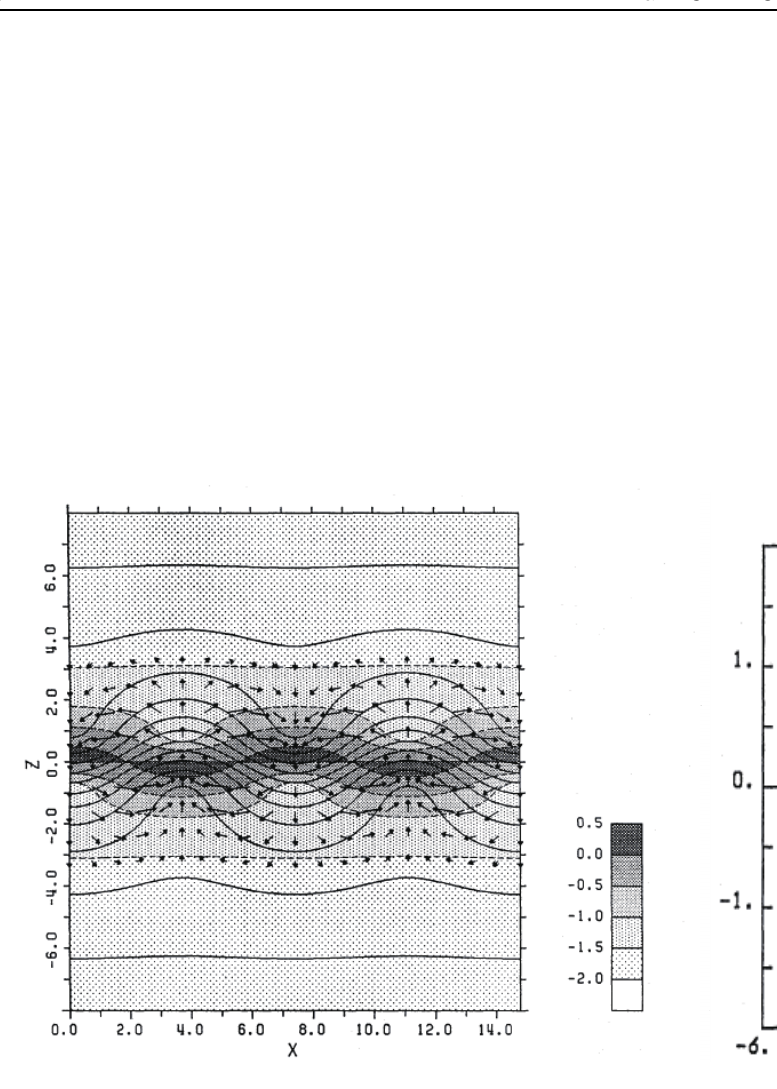
Figure 16: The eigenfunction of the undular mode. Image reproduced with permission from Horiuchi et al. (1988), copyright by